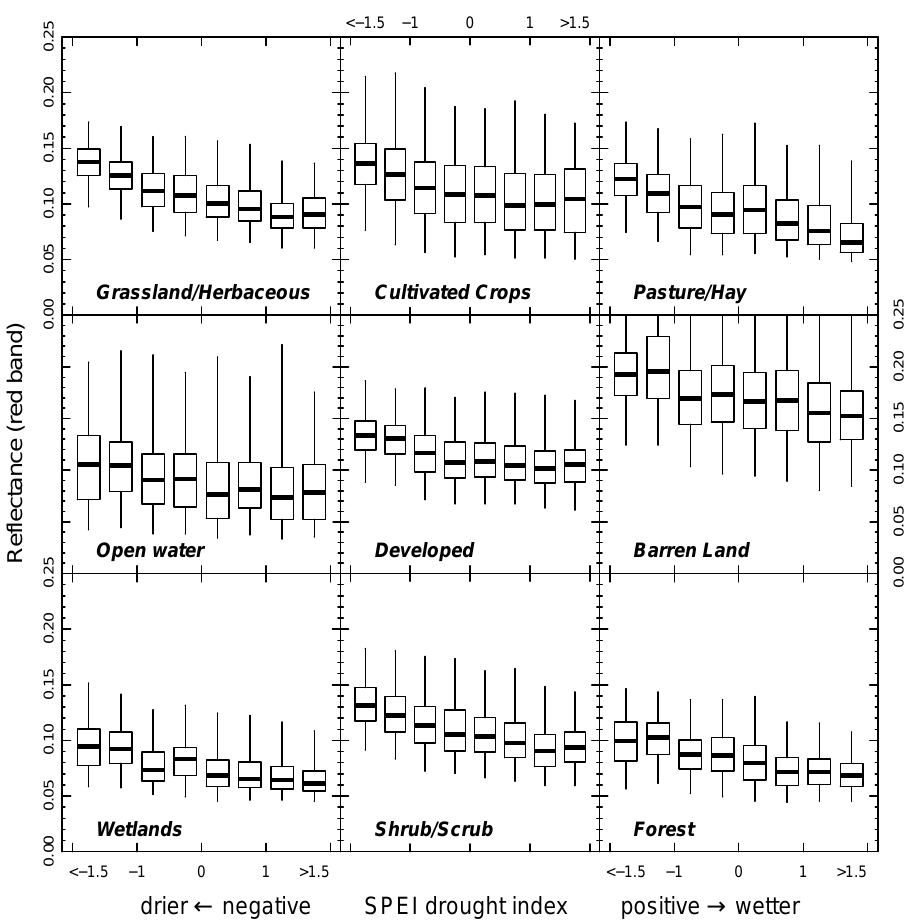
Figure 9. The distribution of reflectance as a function of SPEI for Day of Year 180–220 (June 29–August 8). Pixel counts are weighted so that each year has an equal weight. Boxes denote the 25th, 50th, and 75th percentiles; whiskers are the second and 98th percentiles. The boxes on the ends contain all points with SPEI < − 1.5 and > 1.5. The SPEI values are for nine months. Data for all bands and day of year are included in Supplementary Materials